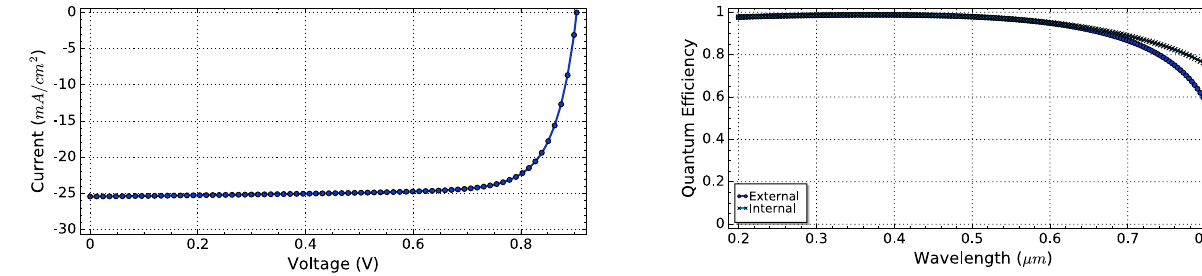
Fig. 6. Current – voltage characteristic of the InGaN PN solar cell at the optimum.